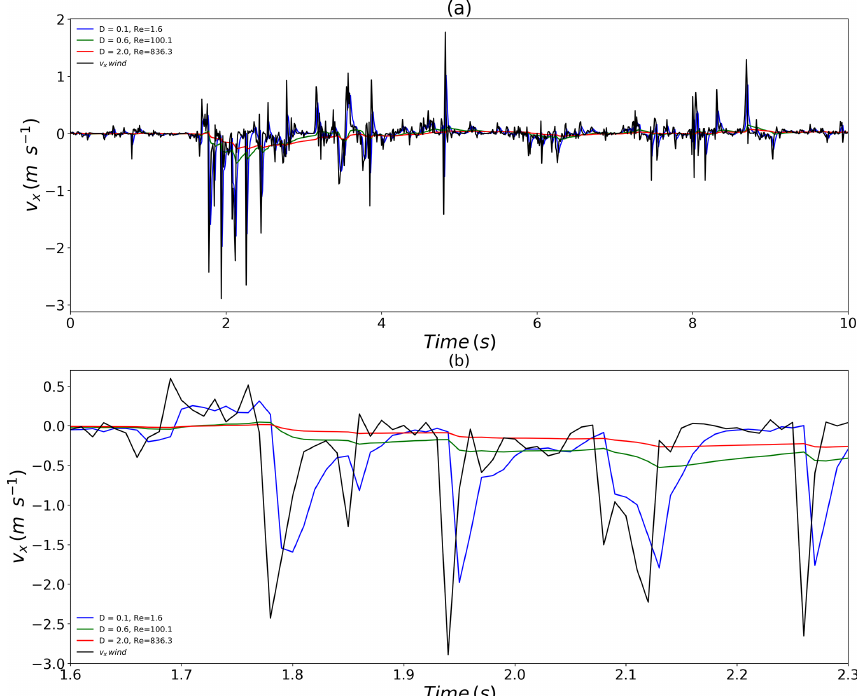
Figure 3. (a) Temporal evolution of the drop horizontal velocity during 10s for various drop diameters (the equivolumic diameter is indicated) with the same multifractal wind input (black). (b) A zoom of the above curve on a shorter period.